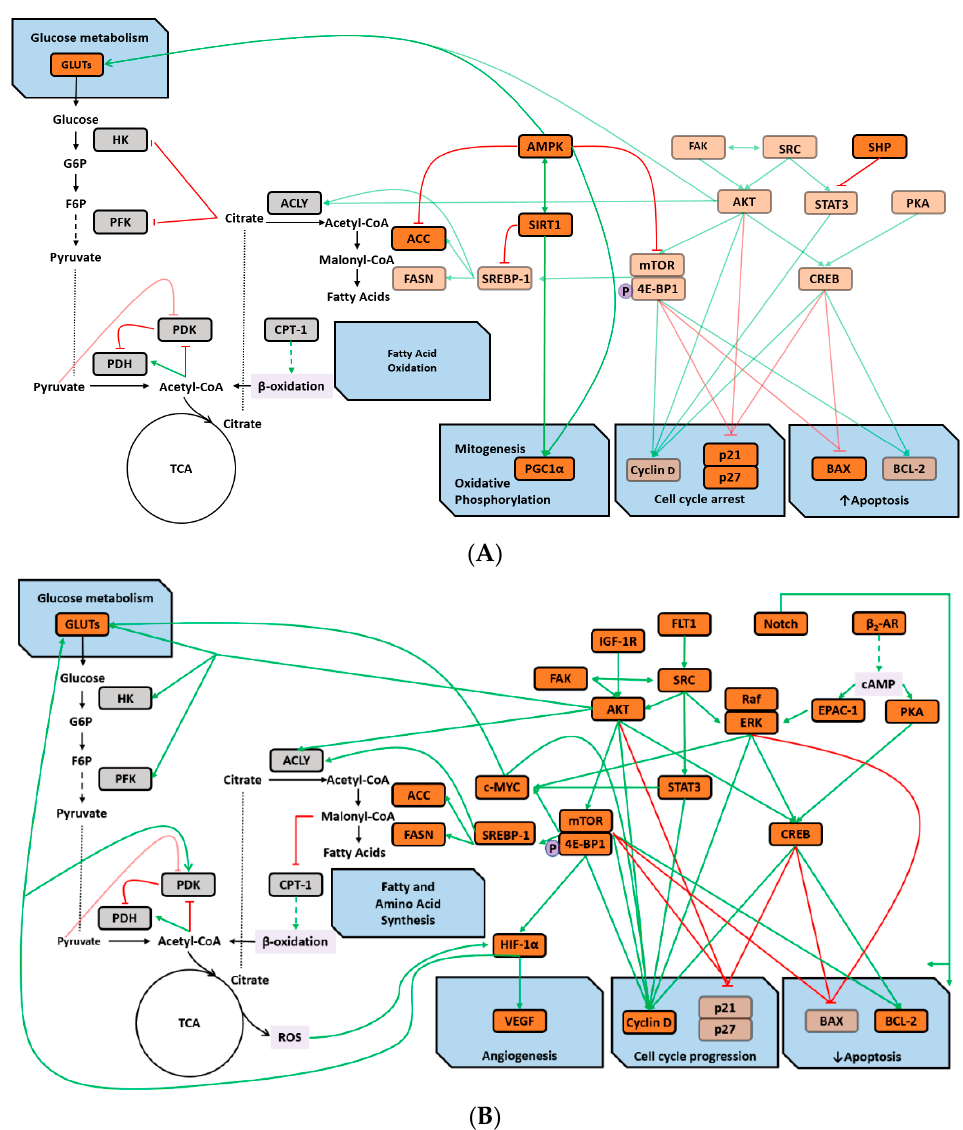
Figure 5. Metabolic and signaling pathway crosstalk in tissues of animals with high inherent aerobic capacity (HIAC) and animals with low inherent aerobic capacity (LIAC). ( A ) Greater fatty acid oxidation is upregulated by activity of AMPK and SIRT1 at the expense of glucose metabolism. Acetyl-CoA from TCA and β -oxidation activate PDK and impedes glycolysis from glucose oxidation by inhibiting PDH, whereas post TCA citrate inhibits HK and PFK attenuating glycolysis and undergoes ACLY-mediated conversion into acetyl-CoA. Further carboxylation of cytosolic acetyl-